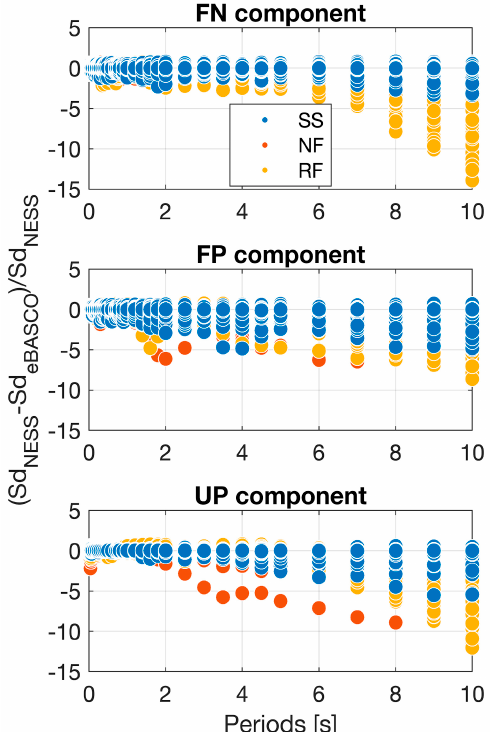
Figure 6. Peak parameters (peak ground displacement (PGD), peak ground velocity (PGV), and peak ground acceleration (PGA)) retrieved by eBASCO along the fault-normal and fault-parallel (FN and FP) and vertical (UP) components of the ground motion for different style-of-faulting (SS: Strike Slip; NF: Normal; RF: Reverse) compared with NESS.